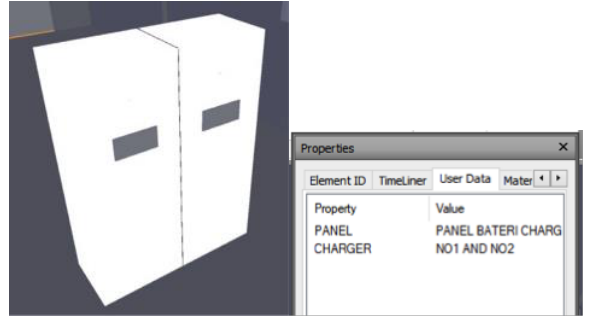
Figure 10: Battery Charger Panel and its Attributes